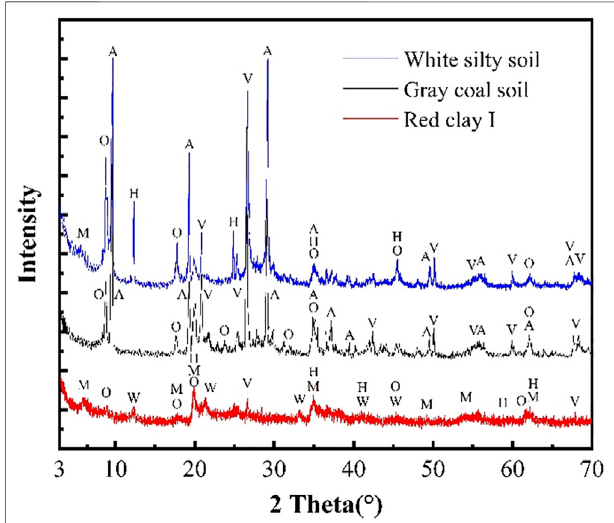
FIGURE 6 | X-ray diffraction spectra of soils in the study area.